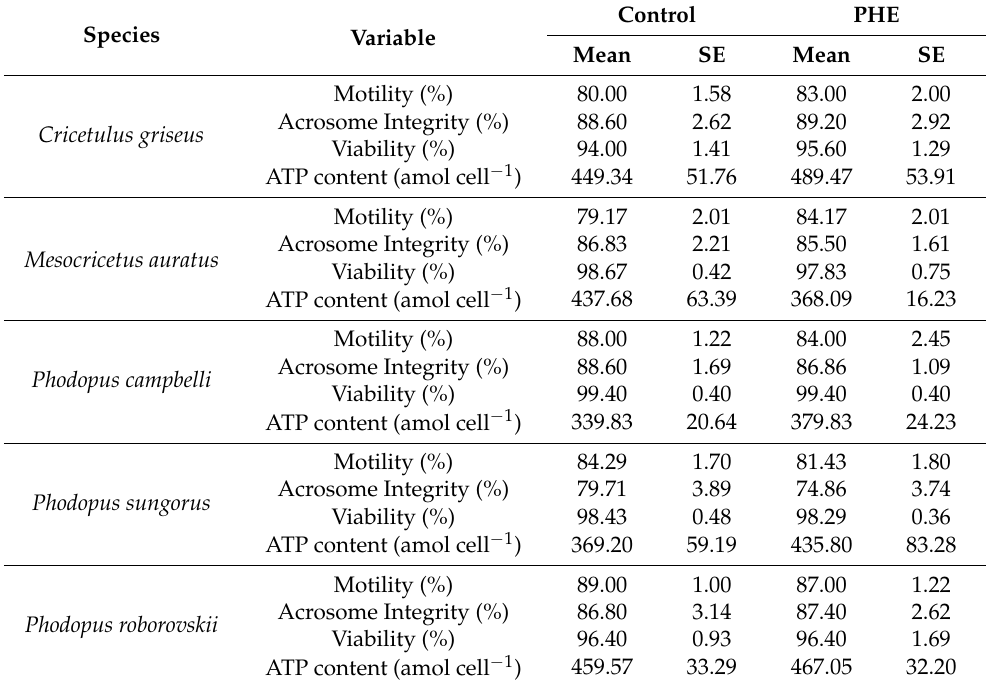
Table 3. Sperm motility, acrosome integrity, viability and ATP content in five hamster species. Values correspond to mean and standard error (SE) for spermatozoa in the absence (control) or presence of penicillamine, hypotaurine and epinephrine (PHE) at the start of the incubation period (time zero).